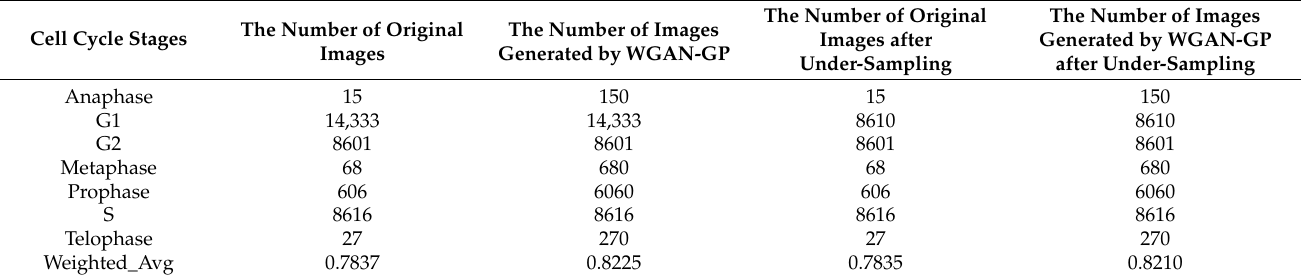
Table 3. Seven-stage classification results of the original images, the images generated by WGAN-GP, the original images after under-sampling, and the images generated by WGAN-GP after under-sampling. Cell Cycle Stages